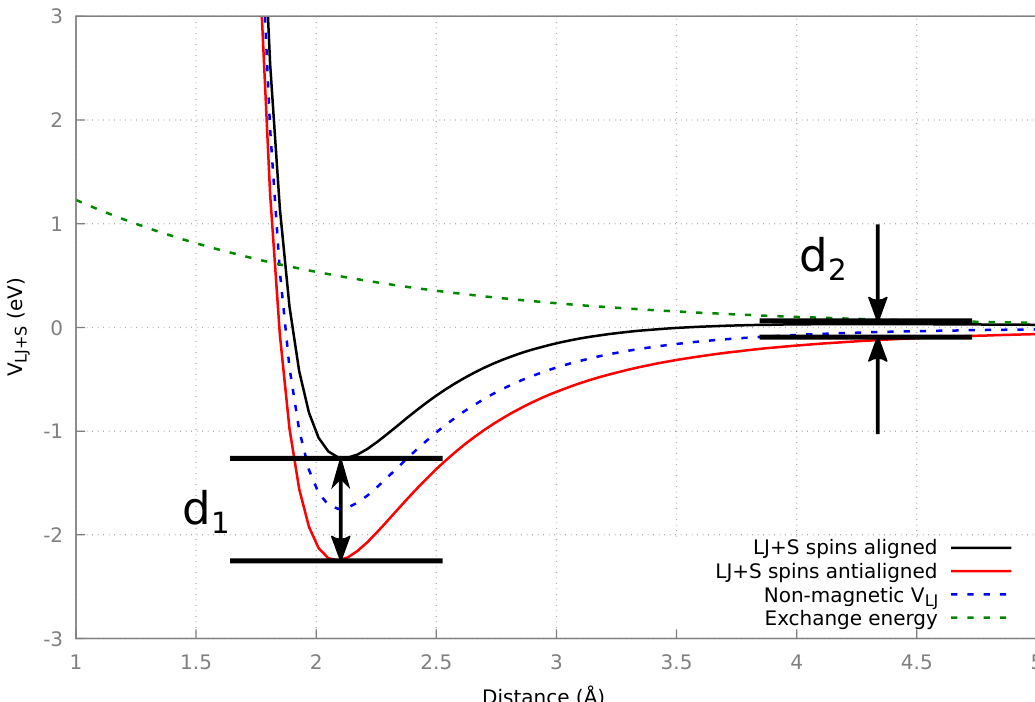
Figure 7. Analytic form of the LJ+S potential, showing the V LJ + S for aligned and anti-aligned spins (solid black/red respectively), along with the contributions from the V LJ and magnetic terms (dashed blue/green respectively). The difference in energy between aligned and antialigned pairs at r min and 2 r min ( d 1 and d 2 respectively) were derived from DFT calculations on an Fe dimer to parameterise the potential.